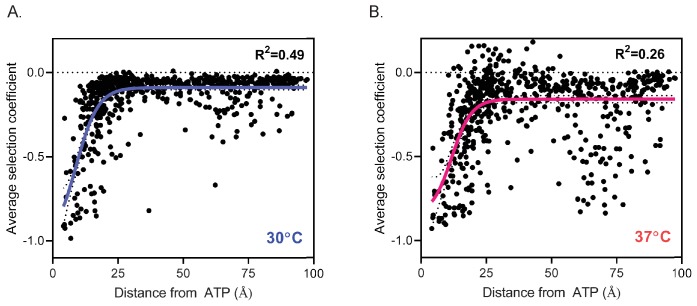
Correlation of mutational sensitivity with distance to ATP.(A) The average selection coefficient at each position in standard (30°C) conditions correlates with distance to ATP (R2 = 0.49). (B) The average selection coefficient at each position at 37°C does not correlate as well with distance to ATP as in standard conditions (R2 = 0.26). The data points were fit to a sigmoid function.